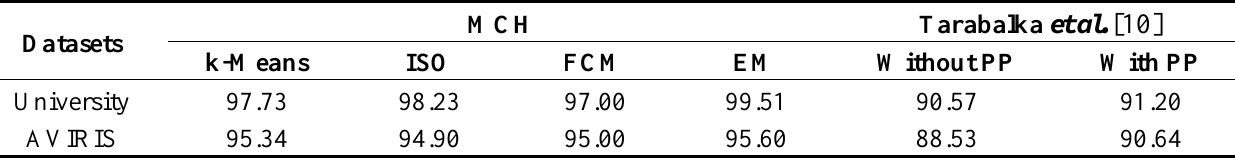
Table 11. Comparison between MCH and the state-of-the art spectral-spatial classification technique of Tarabalka et al. [10] (PP = post-processing for reducing the classification noise). MCH Tarabalka et al. [10] Datasets FCM EM Without PP With